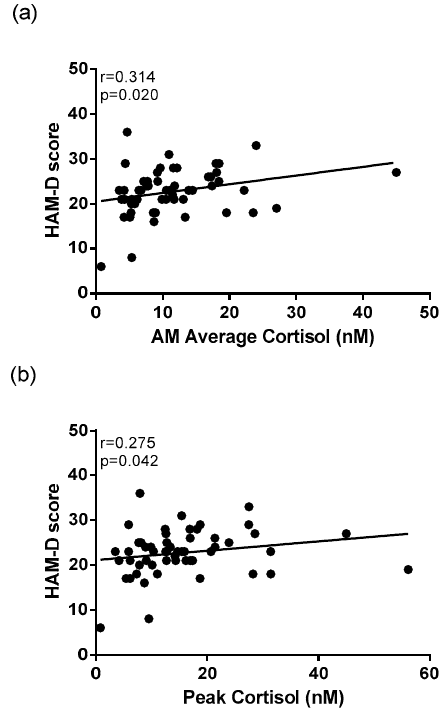
Figure 4. Correlational analysis between depression rating scales and cortisol awakening parameters in MDD patients. A significant positive correlation exists between Hamilton Depression rating scale (HAM-D) scores of depressed patients and ( a ) average morning cortisol concentration, and between ( b ) peak morning cortisol ( n = 55).